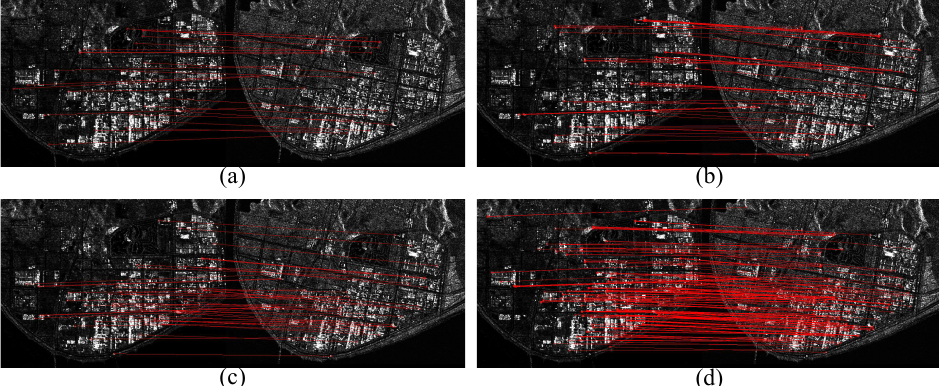
Figure 15. The feature descriptor matching results with different methods for pair 4. ( a ) SAR-SIFT.